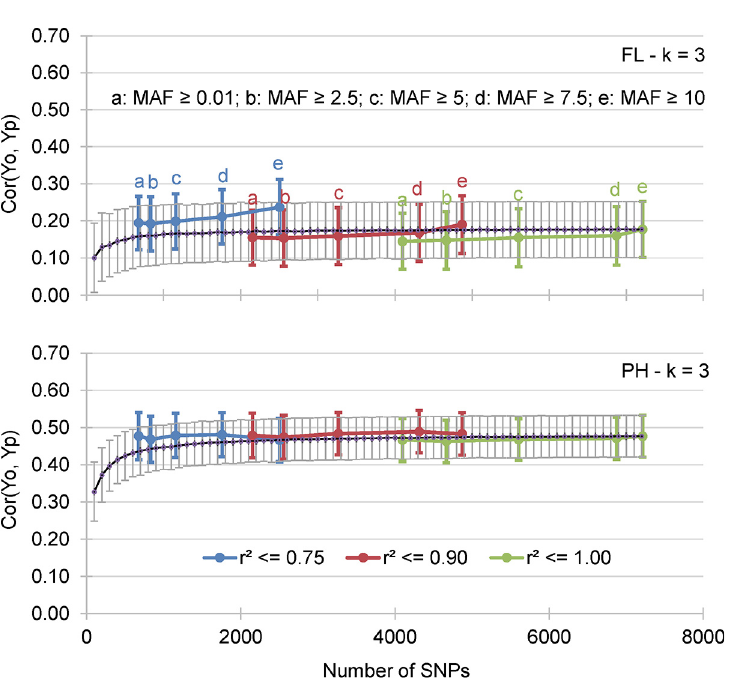
Fig 4. Mean correlation between GEBV obtained by cross validation of the training data set (Yp) and the observed BLUP values of the validation data sets (Yo). The results for flowering date (FL) and plant height (PH) and 15 incidence matrices are